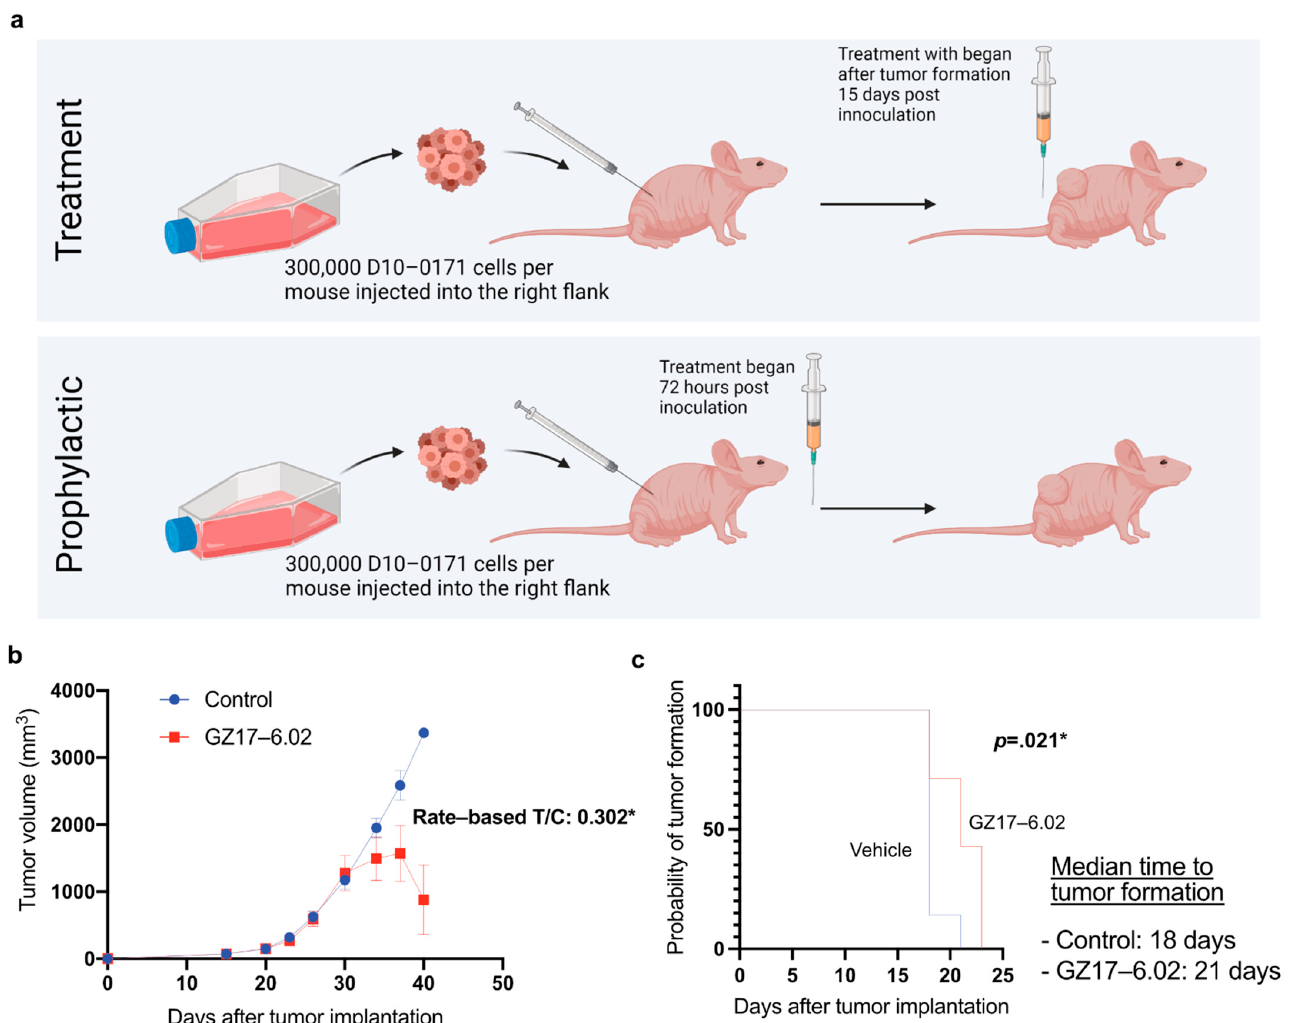
Figure 7. GZ17-6.02 demonstrated anti-tumor activity in a subcutaneous tumor model. ( a ) Flow chart depicting the study protocol with athymic NU/NU mice. This figure was created with biorender.com (accessed on August 20, 2021) ( b ) Average tumor volume per mouse plotted over time in control and treated mice, and analysis of tumor volume data using the rate-based T/C method. A rate-based T/C value below 0.4 indicates that the compound had a significant effect on tumor growth. ( c ) Kaplan–Meier analysis of tumor onset demonstrating that GZ17-6.02 delays tumor formation. * denotes a significant value. n, number of animals; T/C, tumor/control.